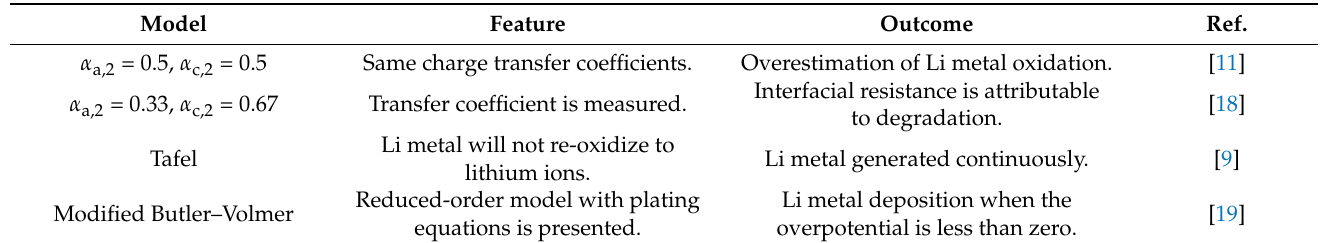
Table 1. Reaction kinetic models for various lithium metal depositions. Model Feature Outcome Ref. α a,2 = 0.5, α c,2 = 0.5 Same charge transfer